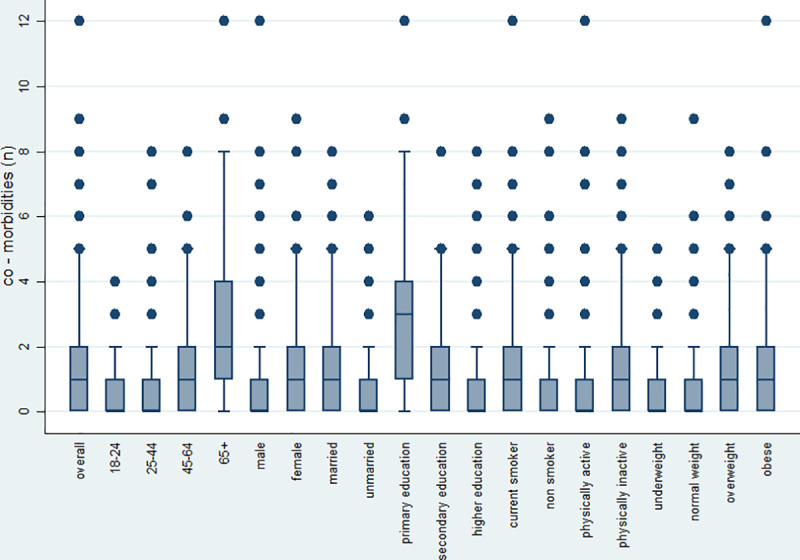
Distribution of co-morbidities overall and by age group, sex, marital and education status, smoking and physical activity level, and obesity status.